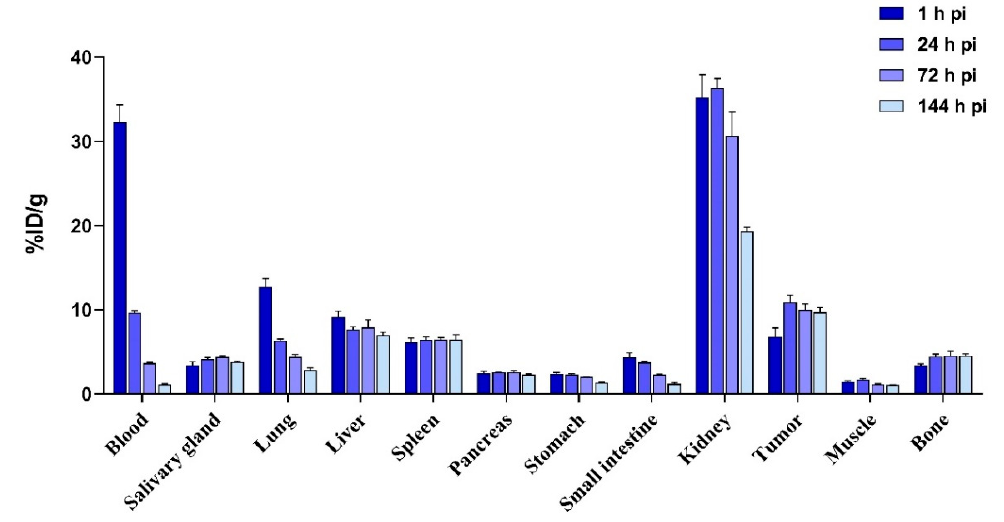
Figure 7. Biodistribution of [ 111 In]In-DOTA-ABD-RM26 at 1, 24, 72 and 144 h pi. The error bars represent the standard deviation.